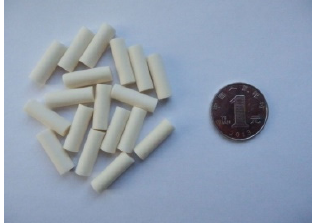
Figure 3. Alumina cylinders (a dime of RMB used for scale).